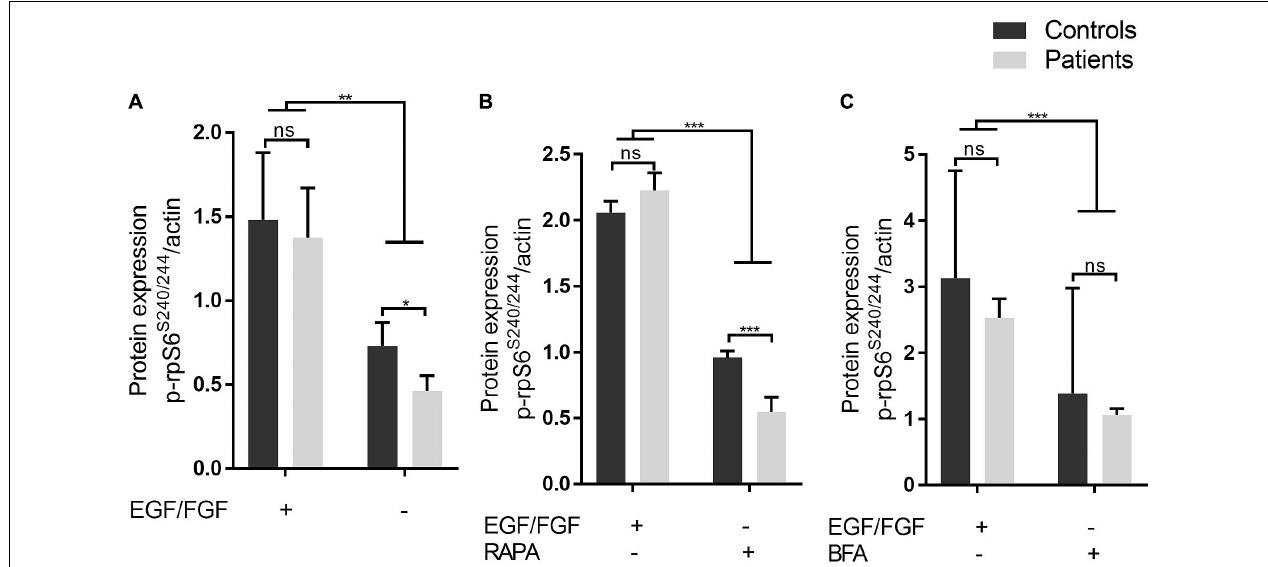
FIGURE 2 | Under stress-inducing conditions, patient-derived iNPC exhibits reduced RPS6 phosphorylation. (A–C) Protein level of phospho-RPS6 (residues S240-244) from iNPC cultivated under normal growth conditions and three stress-inducing conditions. iNPC without epidermal growth factor (EGF) and FGF-2 for 24 h only (A) , without EGF/FGF-2 and concomitant treatment with rapamycin (100 nM) for 24 h (B) , or without EGF/FGF-2 and subsequent treatment with brefeldin A (BFA, 4 µ M) for 3 h (C) . * p -value < 0.05. WB experiments were replicated twice. Data are shown as mean ± SD of technical replicates and biological samples. Patients: F6331-1 and F6331-4 ( N = 2); controls: F7007-1, F8799-1, and F10006-1 ( N = 3). ** p -value < 0.01, *** p -value < 0.001, ns - not